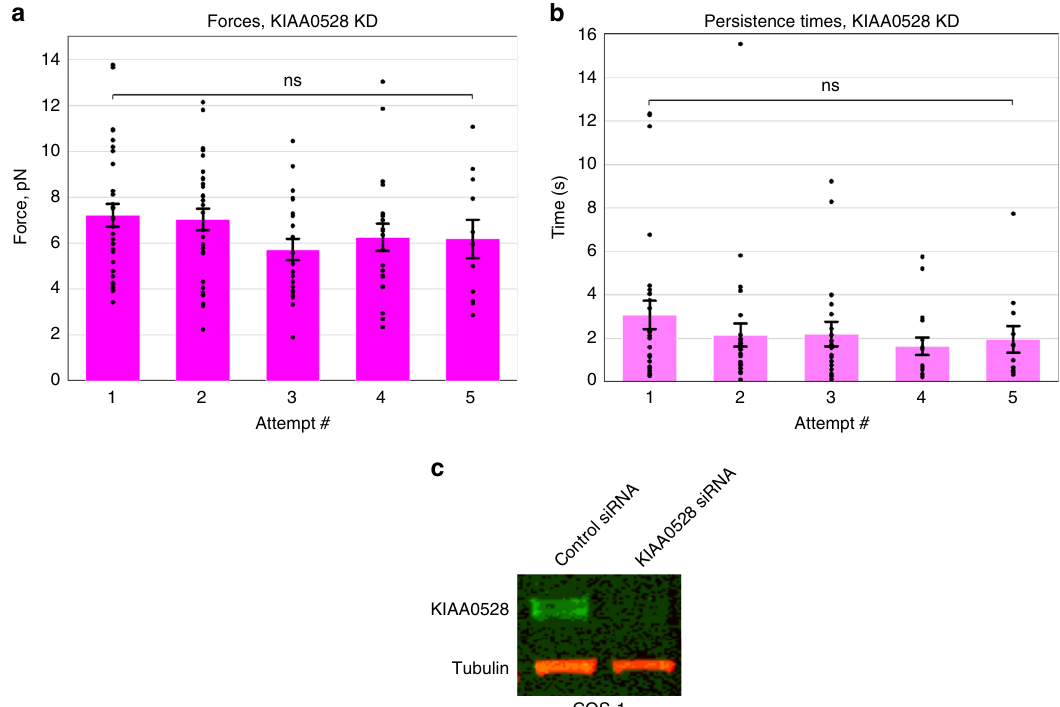
Fig. 5 KIAA0528 is essential for dynein force adaptation in COS-1 cells. Neither average minus-end peak forces ( a ) nor persistence times ( b ) at each attempt increase in the KIAA0528 knockdown background. KIAA0528 knockdown was >99% effective ( c ). Quanti fi ed data represent the mean ± s.e.m. of n = 4 independent experiments. All two-sided t test P values